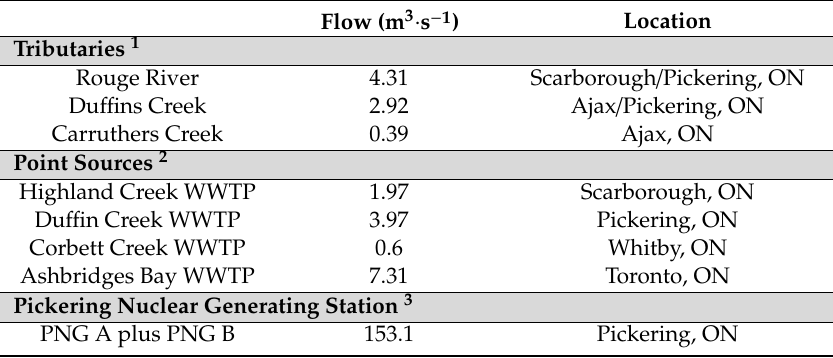
Table 1. Tributary and point source discharges included in the study. Tributary flows are summer (May–September) averages, while those for WWTPs are annual averages for 2014. Data sources are footnoted here and described in detail below. Flows provided here facilitate characterization of study site hydrology, while those for specific periods used in model runs are provided in Table